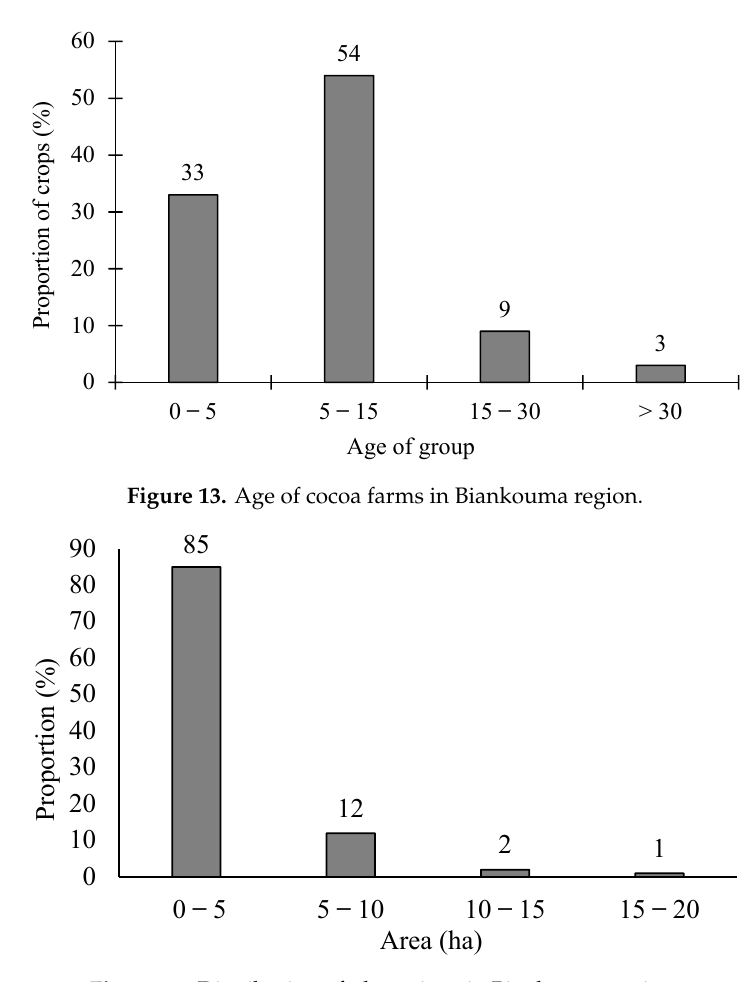
Figure 14. Distribution of plantations in Biankouma region .